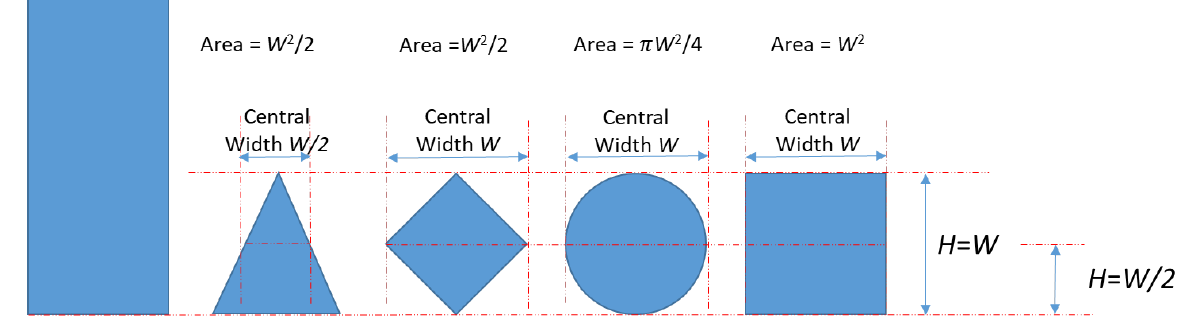
Figure 1. The 1D and 2D targets. The rectangular target is a 1D target with a height greater than its width. The 2D targets are shapes with equal height and width. However, the central width that crosses the half-height ( H = W/2 ) might not be the same.